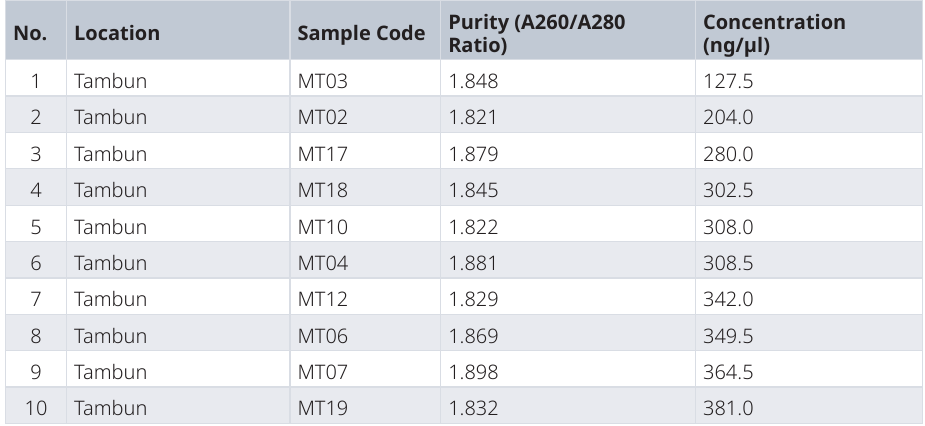
Table 1. Concentrations and purity of DNA extracted from eggshell membrane of Maleo ( Macrochepalon maleo ).